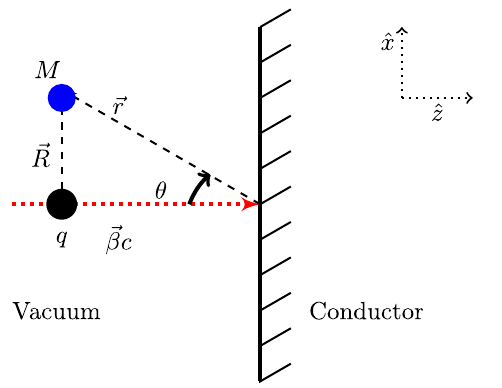
FIG. 19. Schematic of a charge passing by a monitor towards a target where it is normally incident.